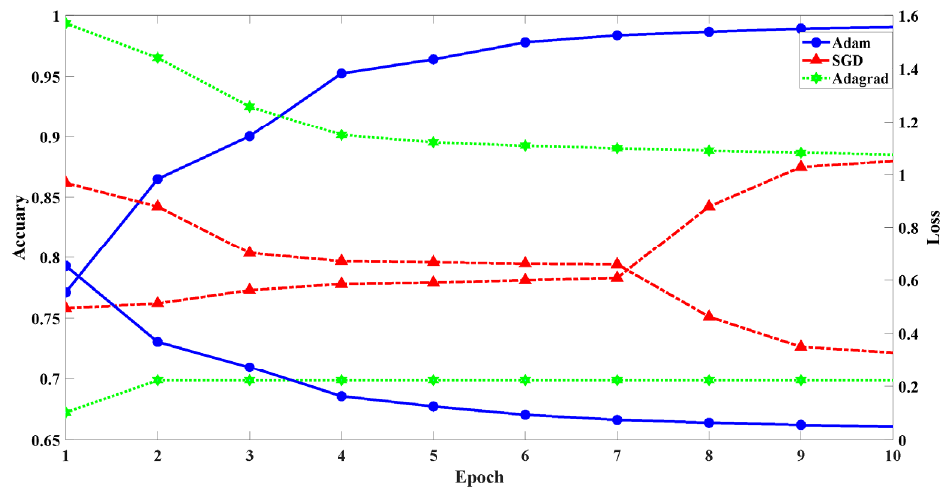
Figure 8. The model performance of different optimizers.